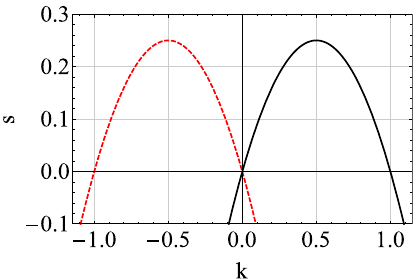
Figure 1 . Dispersion relations s = s + ( k ) (black solid) and s = s − ( k ) (red dashed), defined by eq.